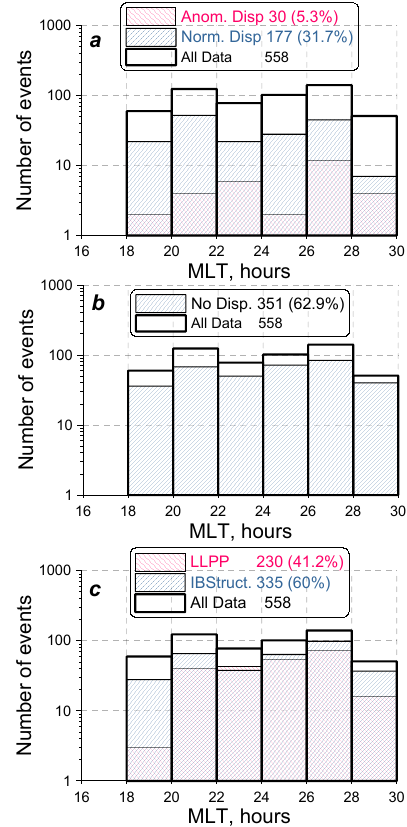
Figure 7. MLT distribution of different IB dispersion types (a) and for the groups showing structured IBs and LLPP (b)